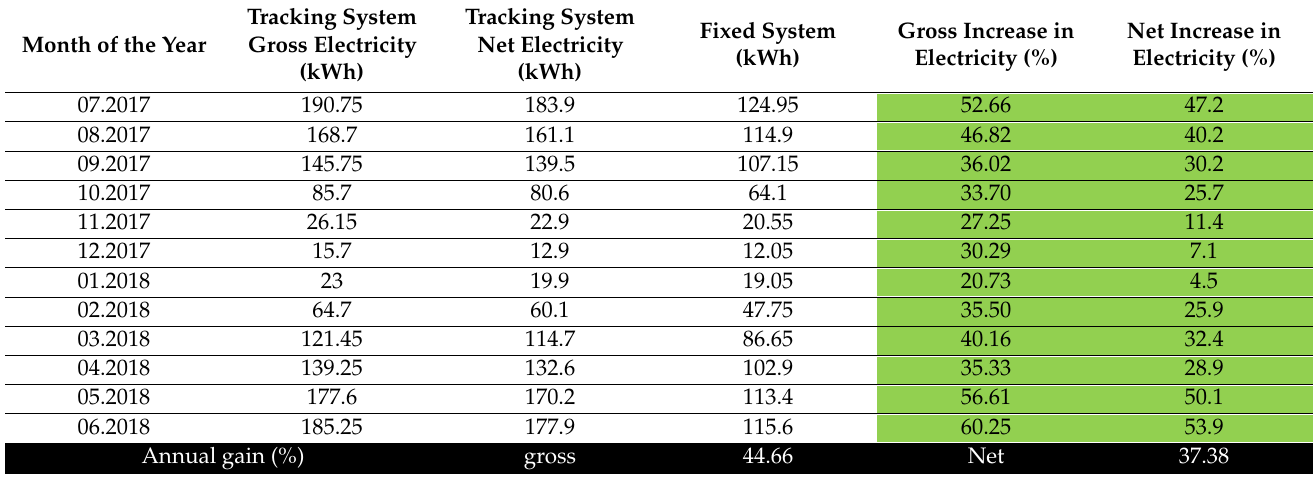
Annual gain (%) Table 7. Percentage gain and value of electricity produced by the dual-axis tracking system and fixed system in the period between 07.2017 and 06.2018.